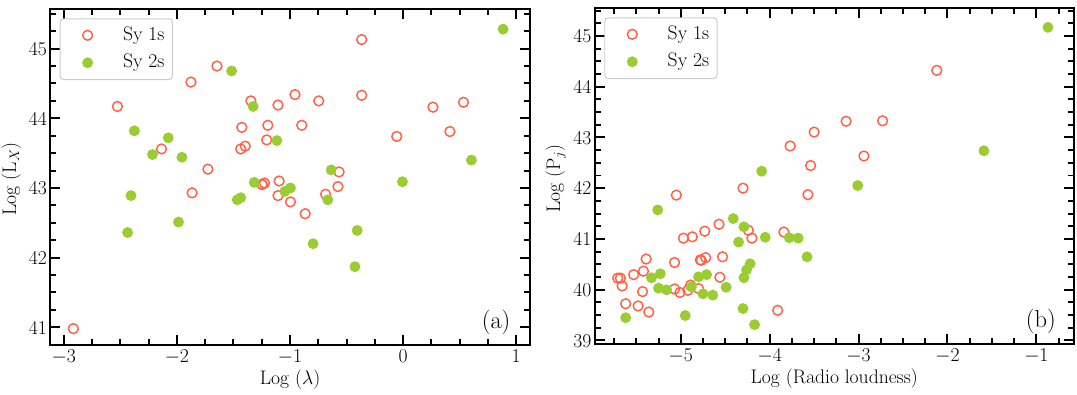
Figure 1. ( a ) Log (X-ray luminosity in 2–10 keV) vs. Log (Eddington ratio λ ) for Seyfert 1s (red) and 2s (green). ( b ) Log (jet power in ergs − 1 ) vs. Log (radio loudness) for Seyfert 1s (red) and 2s